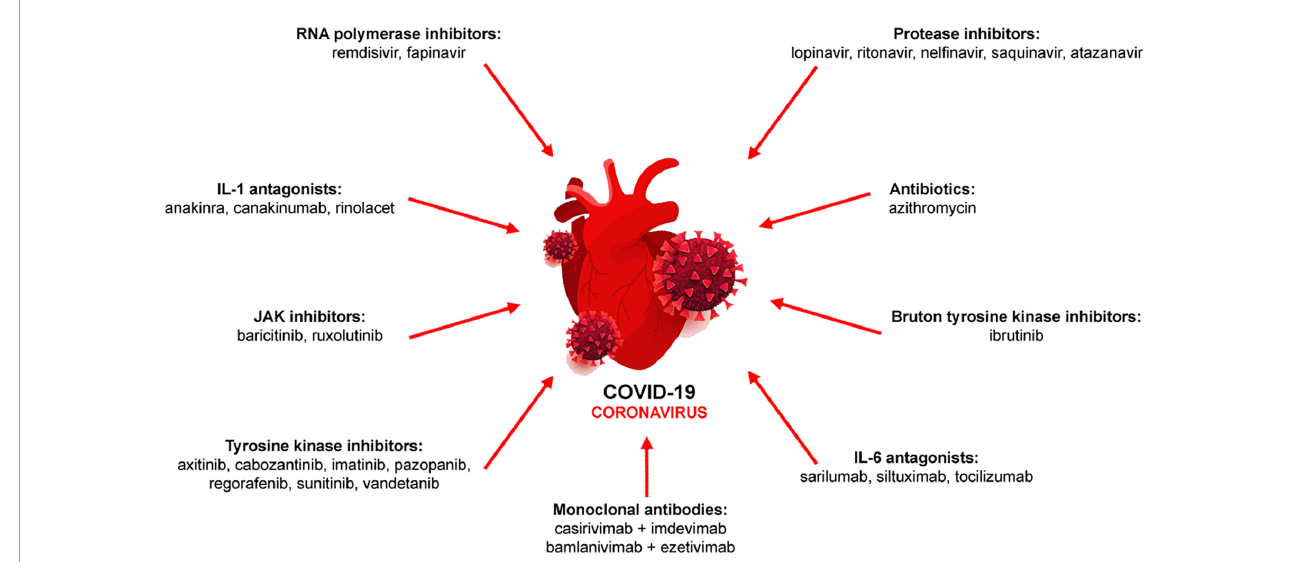
FIGURE1 Pharmacological therapy of COVID-19. Antiviral (RNA polymerase and protease inhibitors, monoclonal antibodies), immunomodulatory (IL-1 and IL-6 antagonists, JAK inhibitors) or other drugs (antibiotics, tyrosine kinase inhibitors) are used either alone or in combination.